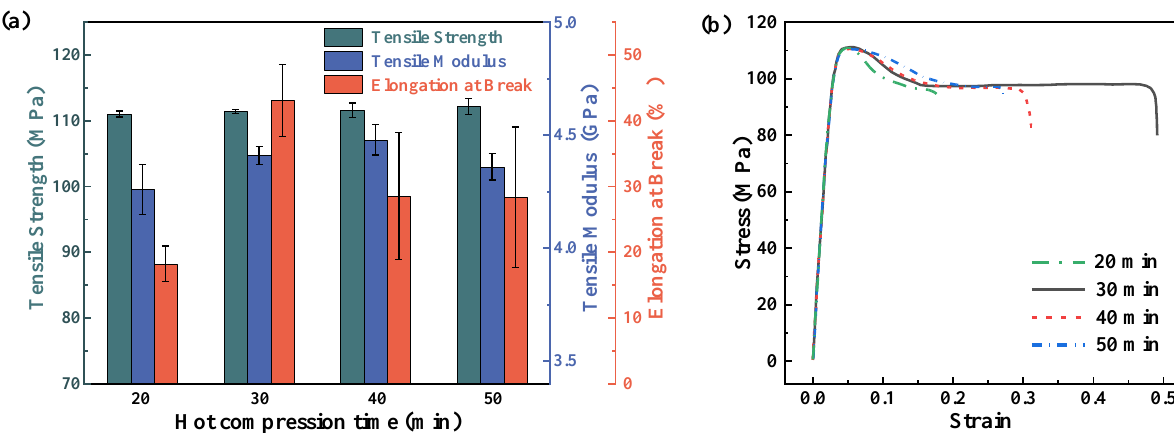
Figure 5. Tensile mechanical performance of PEEK plates under different hot compression times. ( a ) is the variety of different properties of hot compression time. ( b ) is the stress–strain relationship during tensile tests.